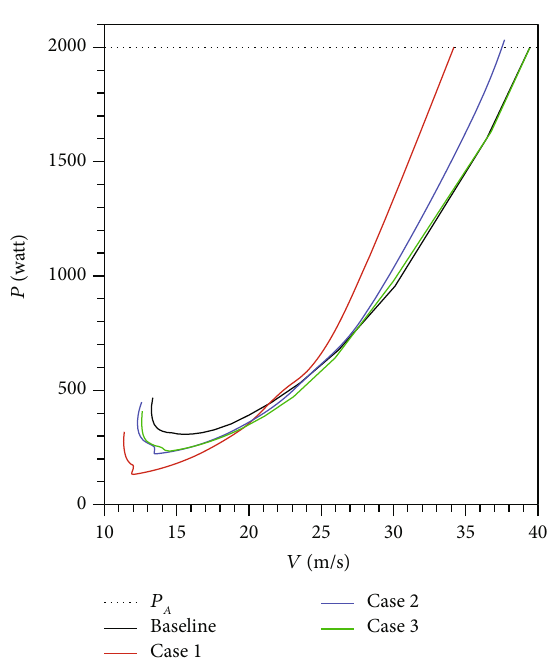
Figure 11: C vs. α curves for the baseline UAV and the optimum L UAV wings.